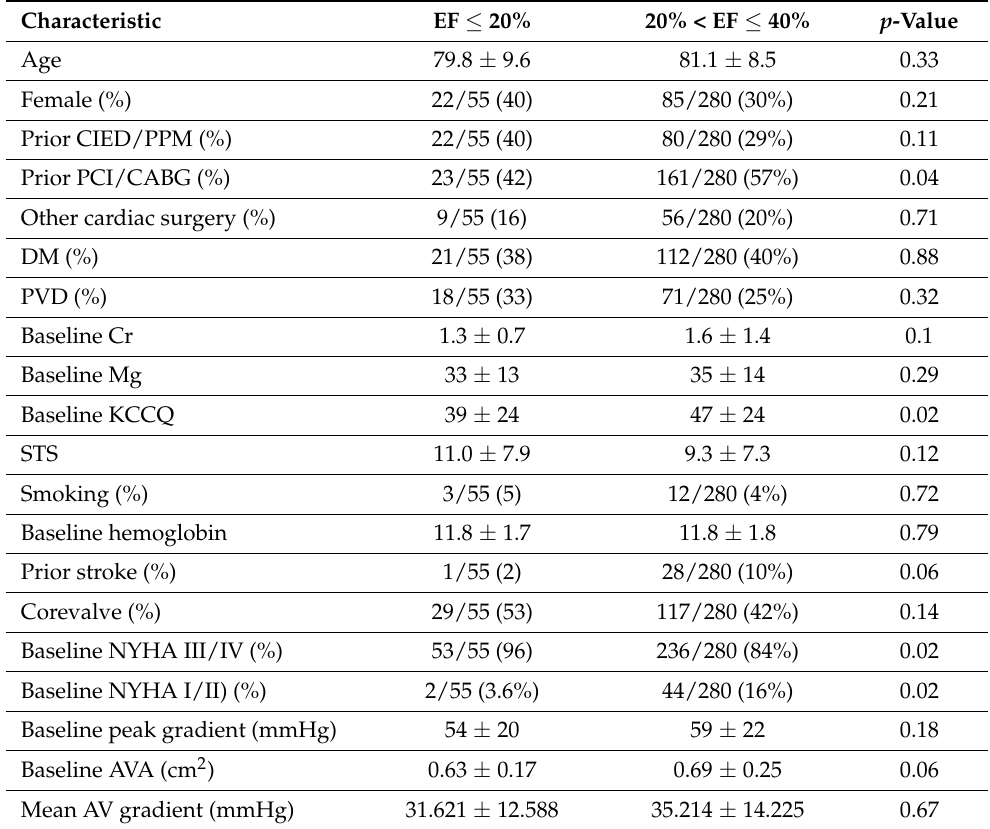
Table 1. Baseline